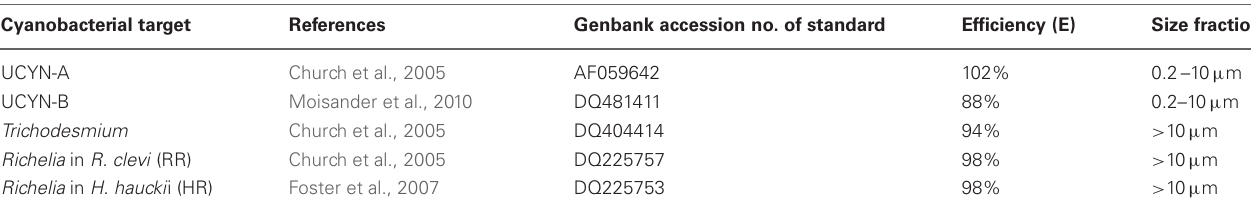
Table 1 | Cyanobacterial nifH qPCR and RT-qPCR